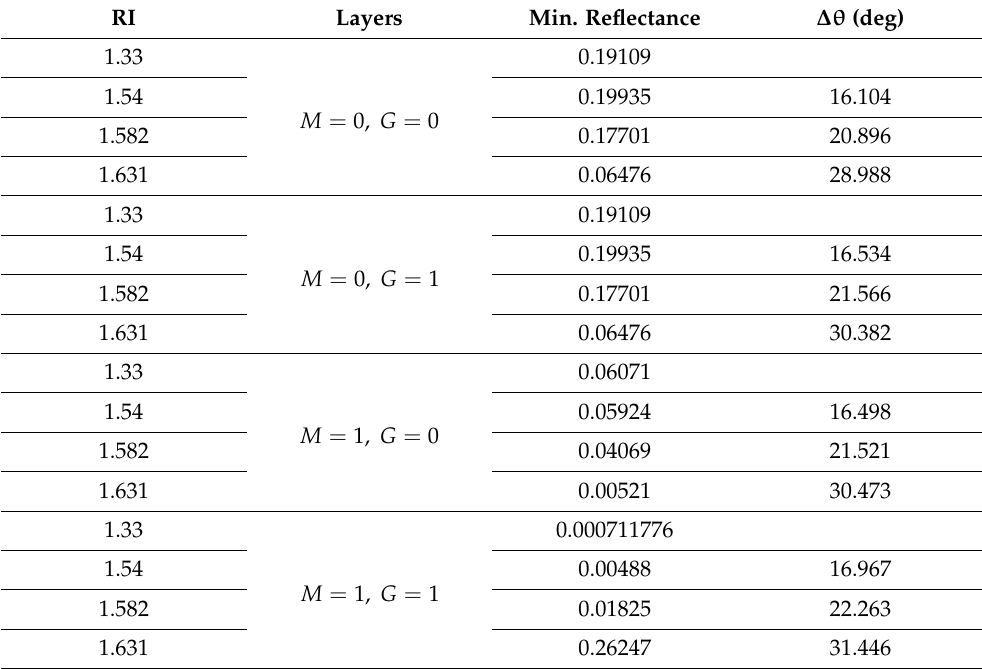
Table 2. Computed minimum reflectance and change in SPR angle values. RI